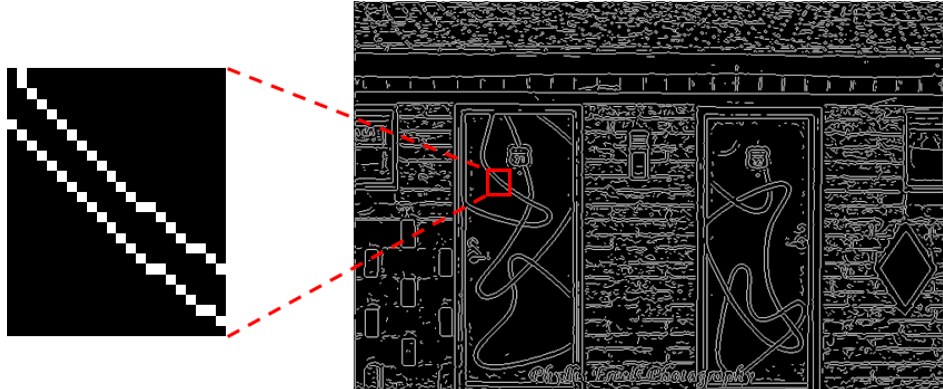
Figure 7. Edge image with optimal edge thinning.